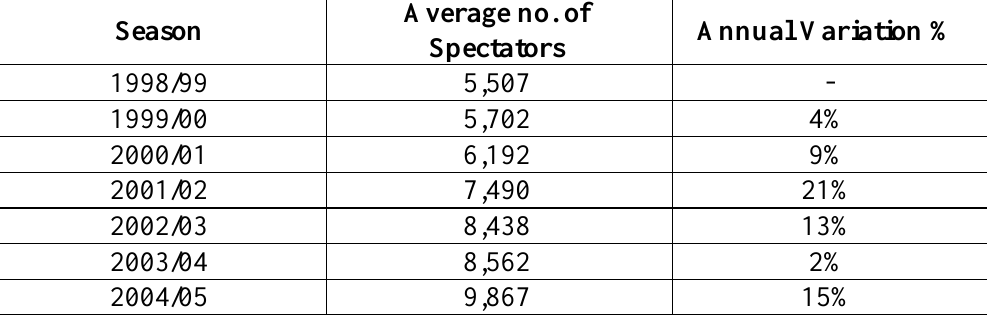
Figure 1 : Average Premier Rugby Attendances Season